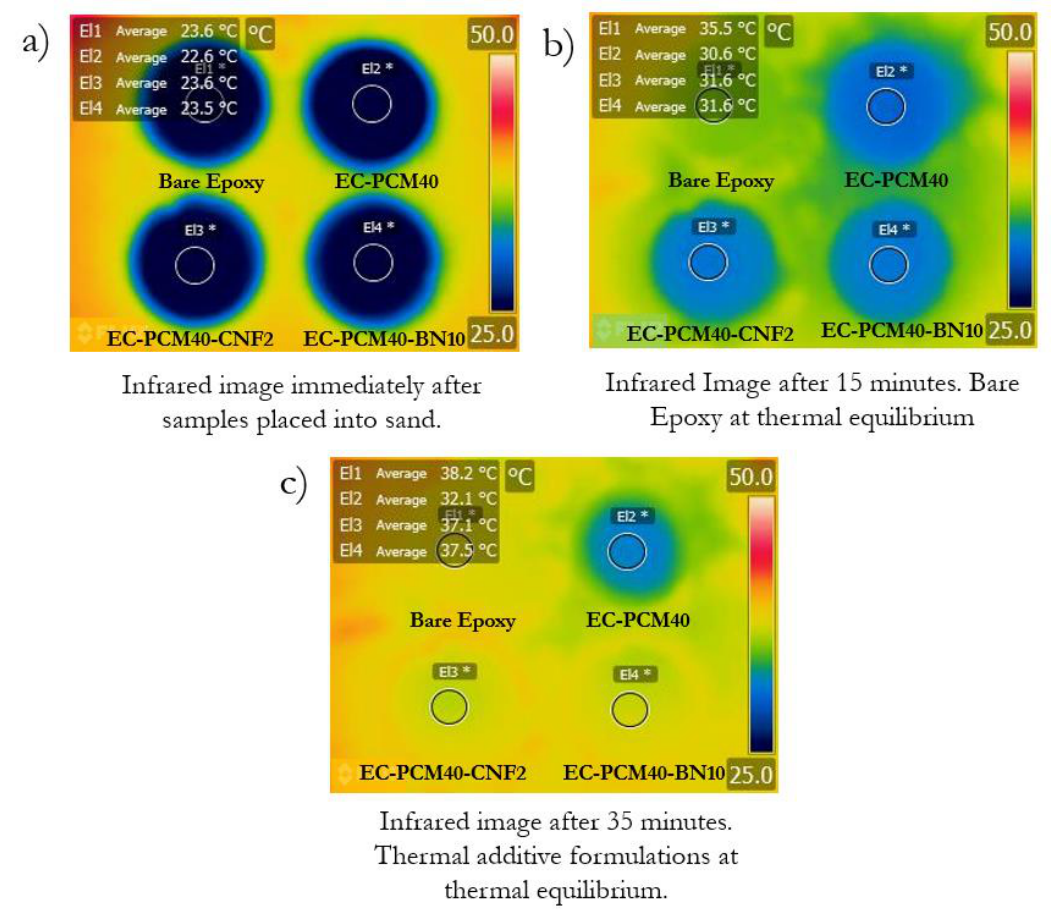
Figure 7. Infrared images of the bare epoxy, EC-PCM40, EC-PCM40-CNF2, and EC-PCM40-BN10 samples taken at different time intervals in the sand-bath experiment.